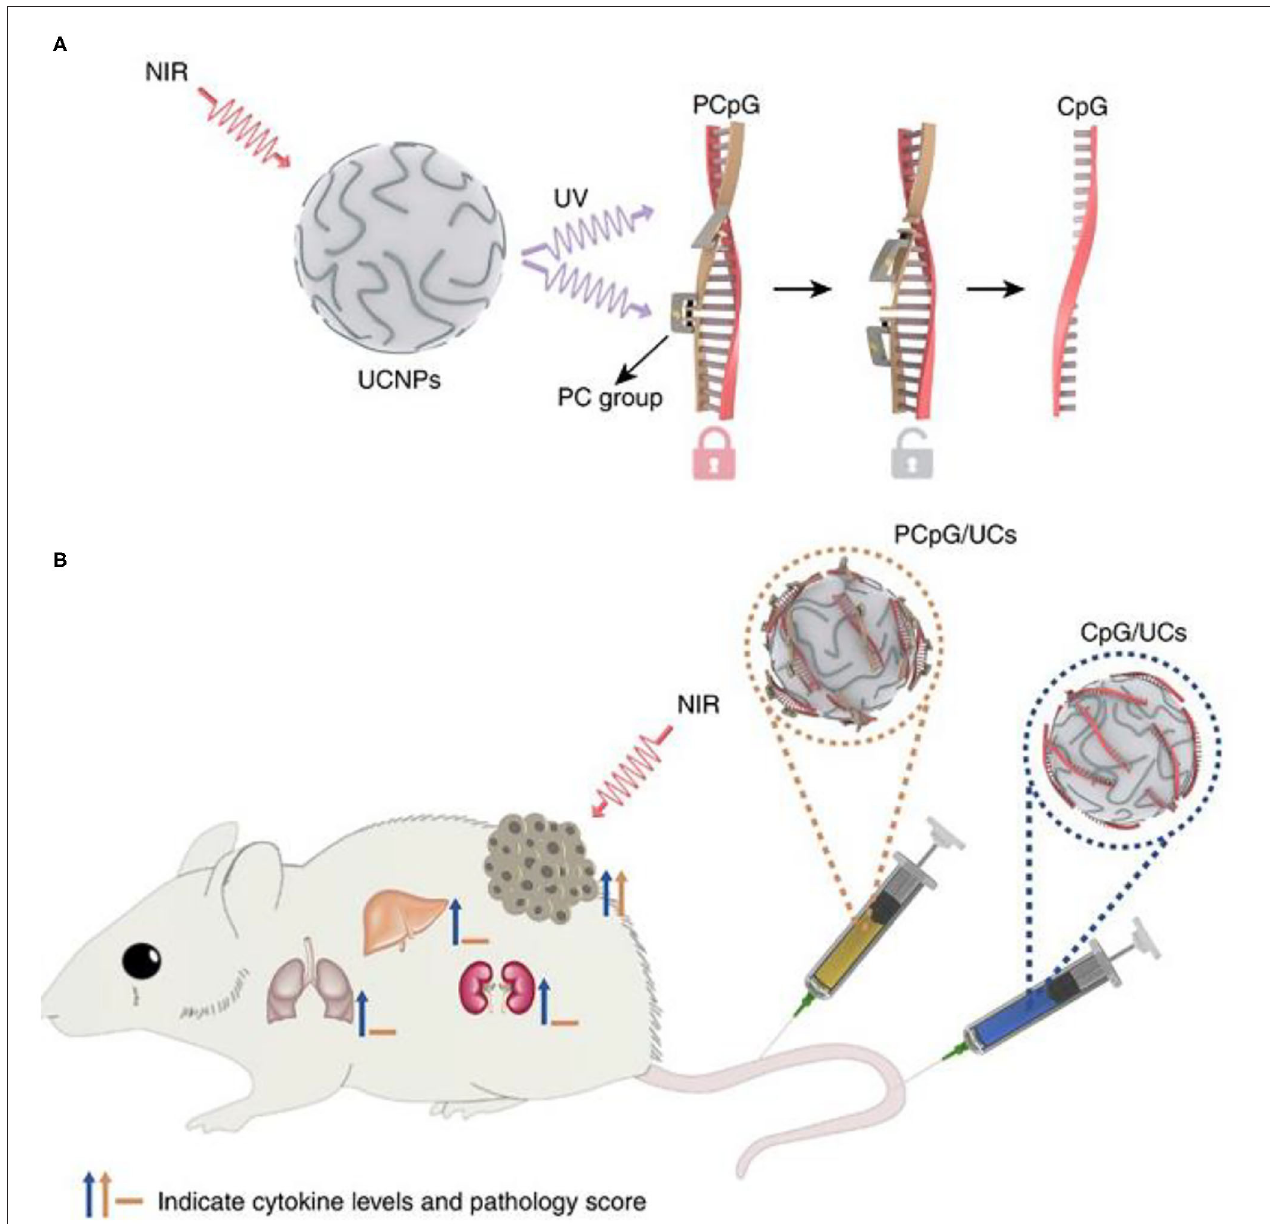
FIGURE 11 | Programming of photoactivatable immunodevice. (A) Schematic of the design of photoactivatable immunodevice through the integration of UCNPs with the UV light-responsive PCpG. UCNPs act as transducer to upconvert NIR light into UV light locally, thus liberate CpG ODN from PCpG to achieve the refined temporal control on its immunoactivity. (B) Illustration of the photoactivatable immunodevice, PCpG/UCs, for spatially selective triggering of immunoactivity through NIR light irradiation. In contrast to traditional CpG delivery system (CpG/UCs), PCpG/UCs is amenable to personalizing the antitumor modality with reduced systemic toxicity. Copyright 2019, Nature Publishing Group (Chu et al.,